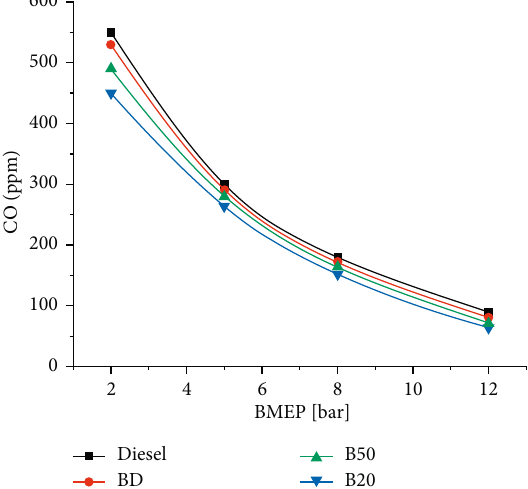
Figure 4: Torque vs